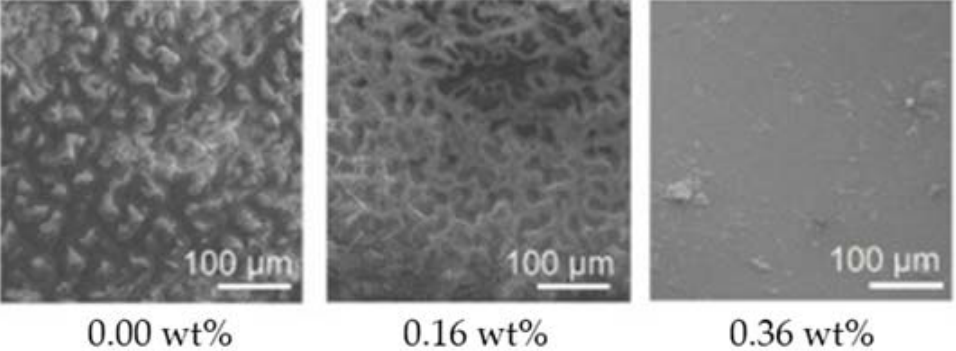
Figure 5. Scanning electron microscopy (SEM) images of diatom adhesion on silicone surfaces containing different GO loadings, after 10 days of incubation under dynamic conditions. Reprinted with adaptations from [64], under the terms of the Creative Commons Attribution (CC BY) license.